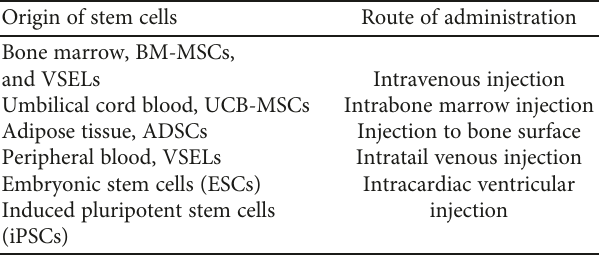
Table 1: Stem cell transplantation in the cell-based therapy of